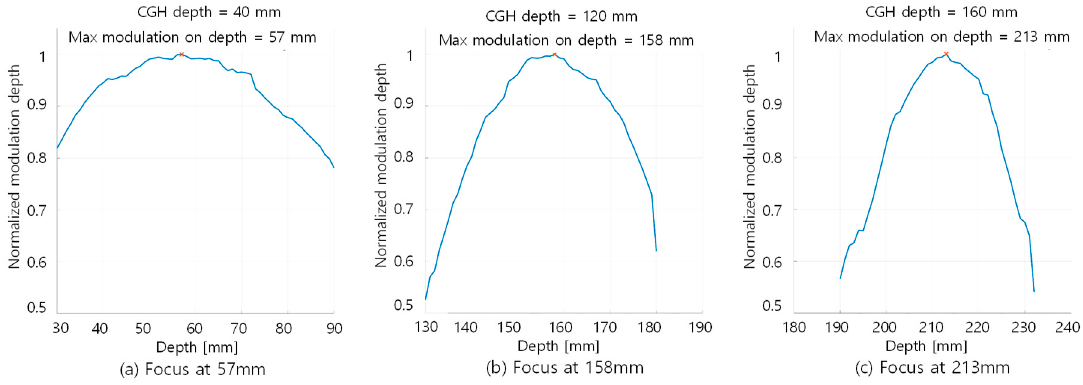
Figure 13. Degree of DoF at different depths, measured with MTF test patterns.